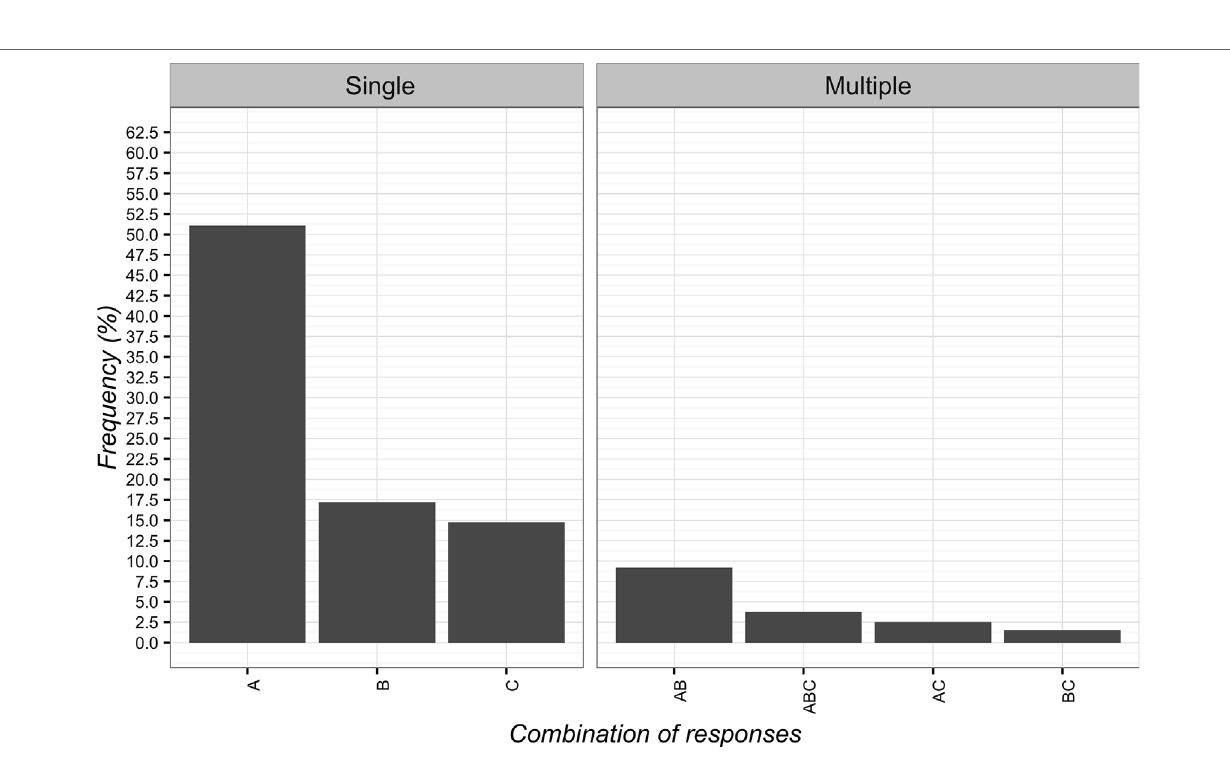
FIGURE 4 | Percentages of responses for not-ethical use of Contextual Factors. (A) it is based on deception; (B) it undermines trust between patient and clinician; (C) the evidence is